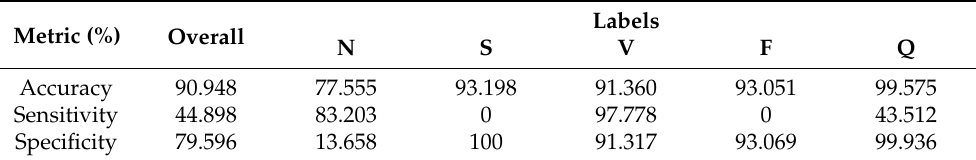
Table 11. Performance metrics of composite model on single-lead ECG signals.